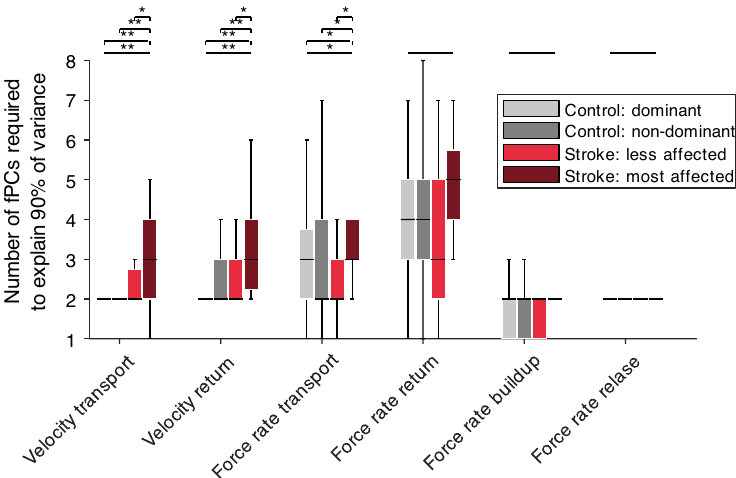
Figure 4. Number of fPCs required to explain 90% of the variance in the input signal. This information was provided for each task phase and modality (end-effector velocity and grip force rate), visualized for the paretic side of post-stroke subjects (dark red), the non-paretic side of post-stroke subjects (light red), the dominant arm of the healthy age-matched control population (light gray) and the non-dominant arm of the healthy age-matched control population (dark gray). Horizontal black line indicates median, boxes represent the IQR, and the whiskers the min and max value within 1.5IQR. Horizontal solid line on top indicates results from an omnibus test and dashed lines from post-hoc tests. *Indicates P < 0.05, ** P <